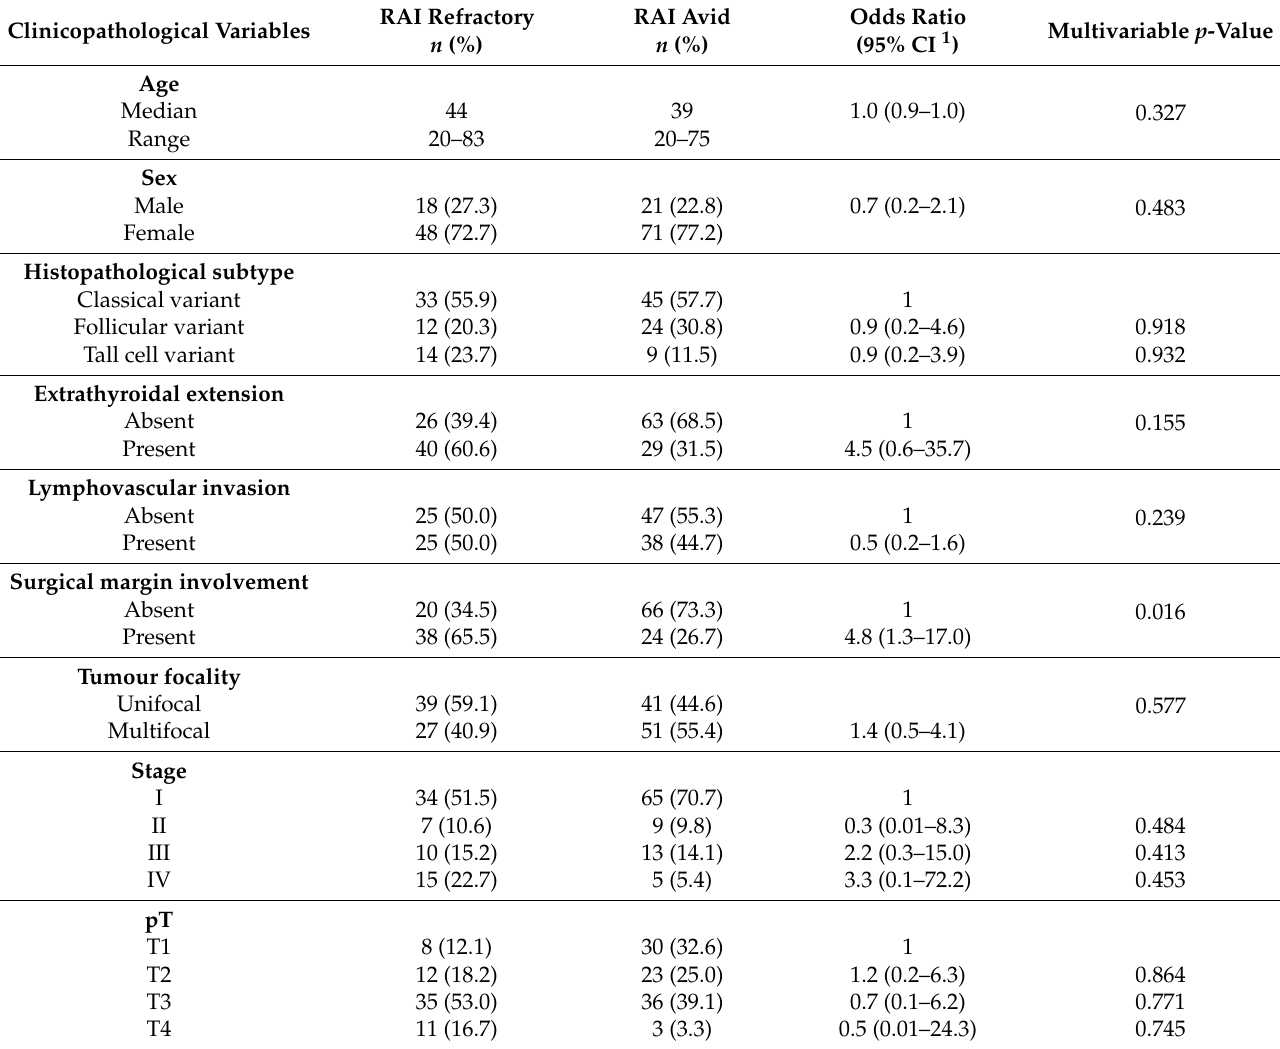
Table 1. Clinicopathological characteristics of radioactive iodine (RAI) refractory ( n = 66) and avid ( n = 92) PTC